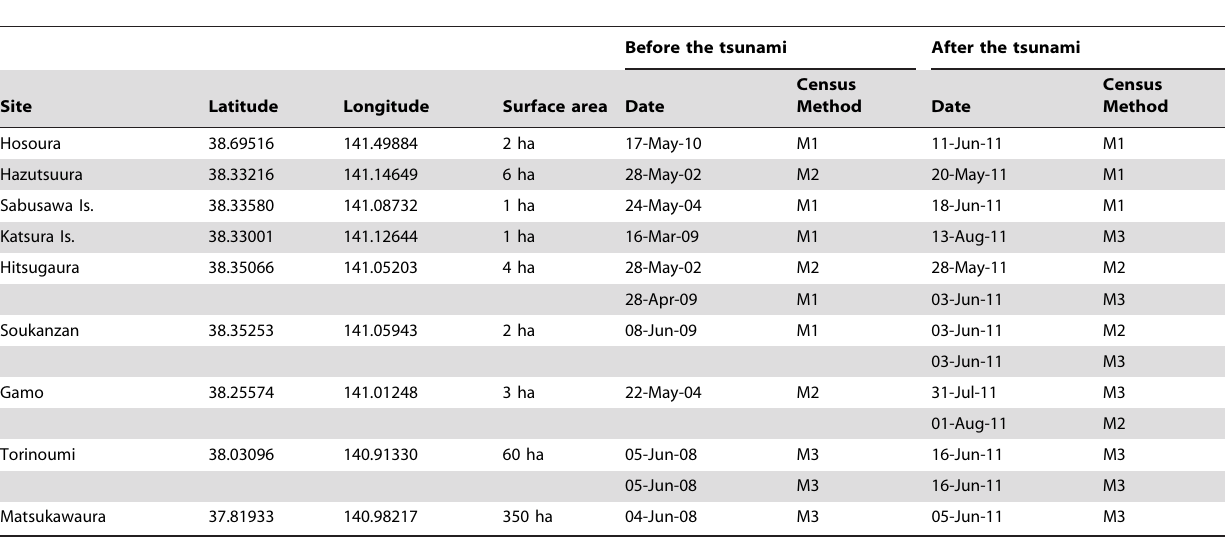
Table 1. Longitude and latitude (expressed in the decimal system) of intertidal flats examined, and date and census methods of the surveys before and after the 2011 Tohoku earthquake tsunami.